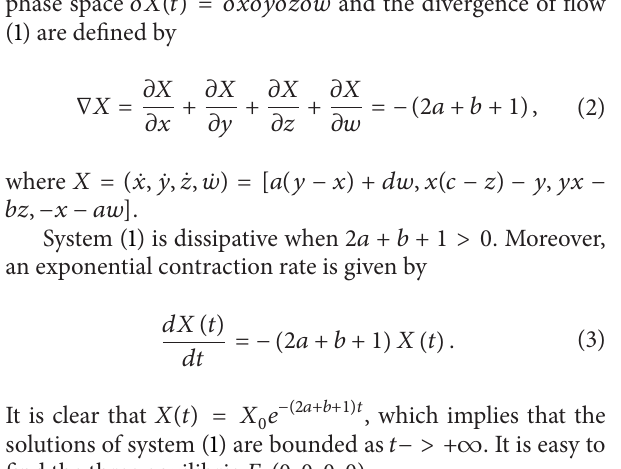
stabilized, respectively. The volume of the elements in the phase space 𝛿𝑋(𝑡) = 𝛿𝑥𝛿𝑦𝛿𝑧𝛿𝑤 and the divergence of flow (1) are defined by